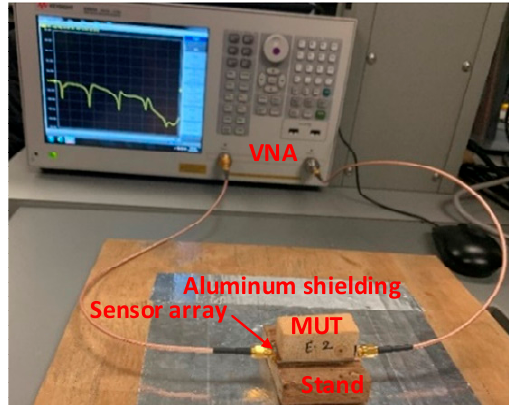
Figure 6. Measurement of | S 21 | for the sensor array using a vector network analyzer (an E5063A ENA from Keysight Technologies).